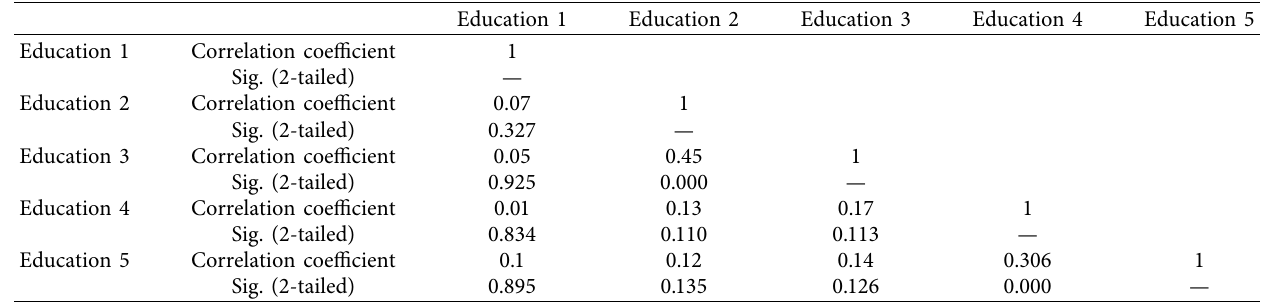
Table 14: Spearman test results for education level variables.